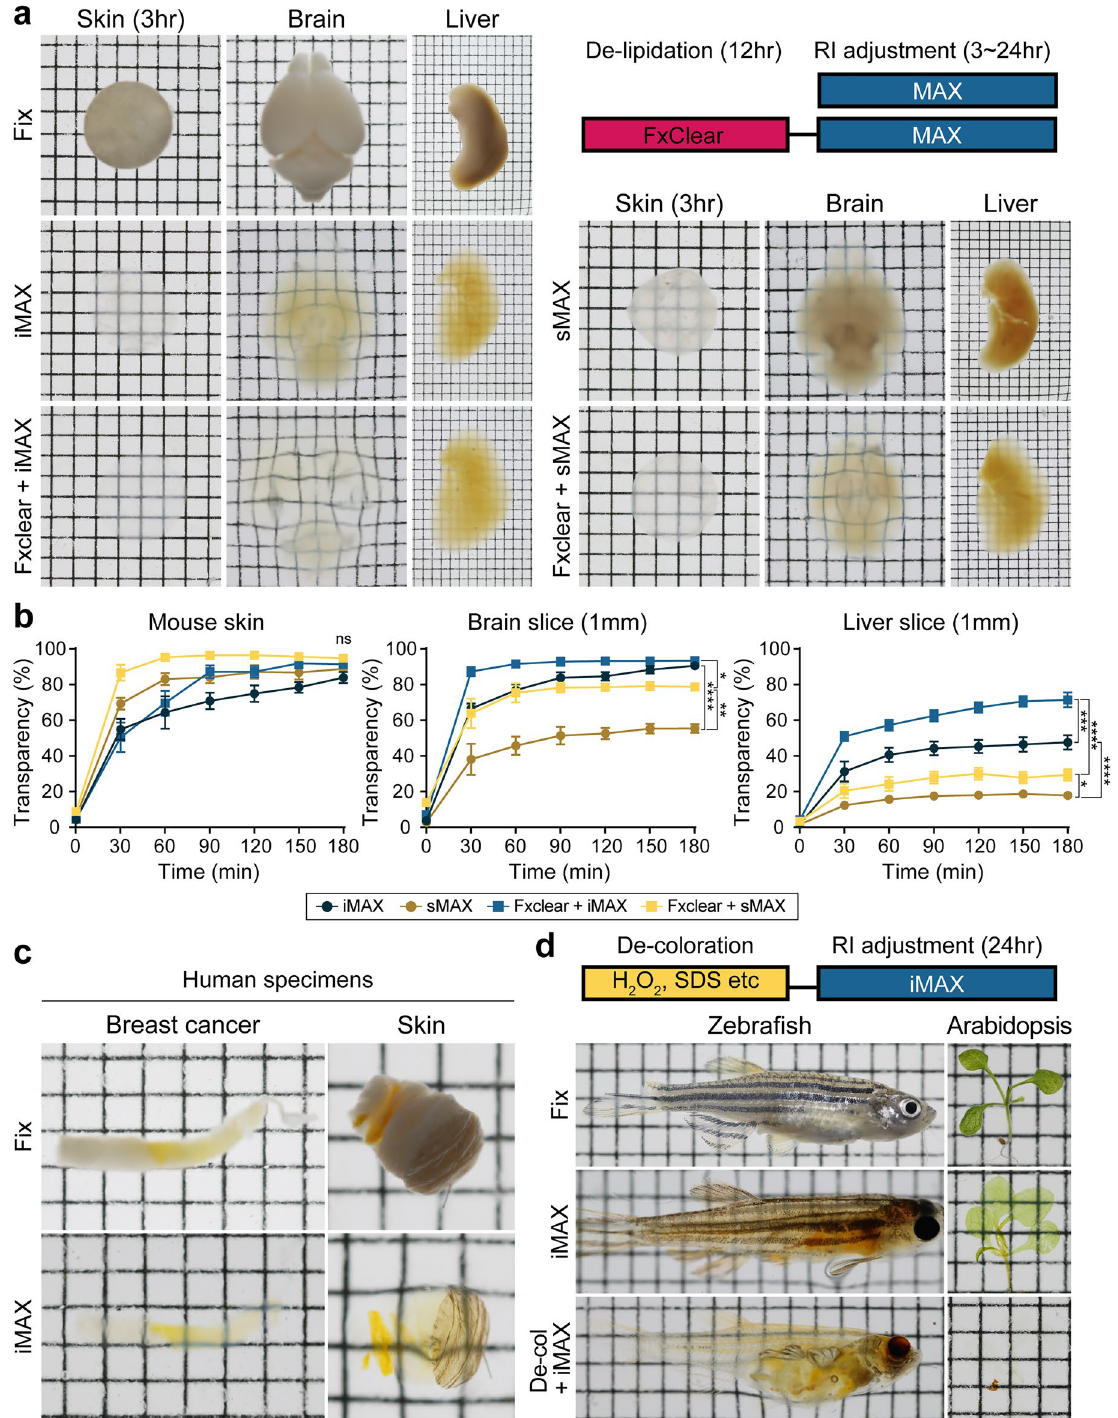
Figure 2. Organ clearing in MAX solutions. ( a ) Fixed mouse organs are immersed in the iMAX or sMAX solutions 3 h (skin) or overnight (brain and liver) with or without FxClear de-lipidation steps. Specimens are placed on the 2-mm grid paper. ( b ) Kinetics of specimen clearing in the MAX solutions. Specimen are prepared with or without FxClear step, N = 4 animals. The unpaired two-tailed t -test was used to analyze the differences in maximum transparency (180 min) between the groups (ns, not significant; * p < .05; ** p < .01; *** p < .001; **** p < .0001). ( c ) Clearing of human specimen in iMAX solution. ( d ) Clearing of whole adult zebrafish and Arabidopsis in iMAX media. Specimen are de-colorized by treatments with H 2 O 2 (zebrafish) or sodium dodecyl sulfate (SDS) (Arabidopsis). All specimens are placed on the 2-mm grid paper. Images were acquired using a Digital Single Lens Reflex camera